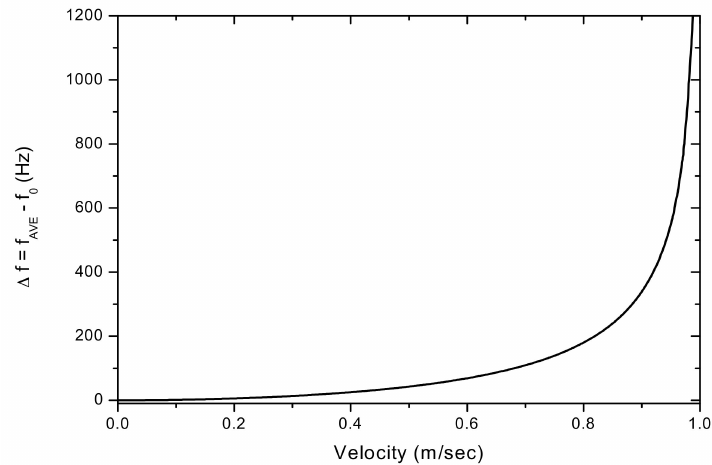
Figure 5. ∆ f as a function of the string’s movement